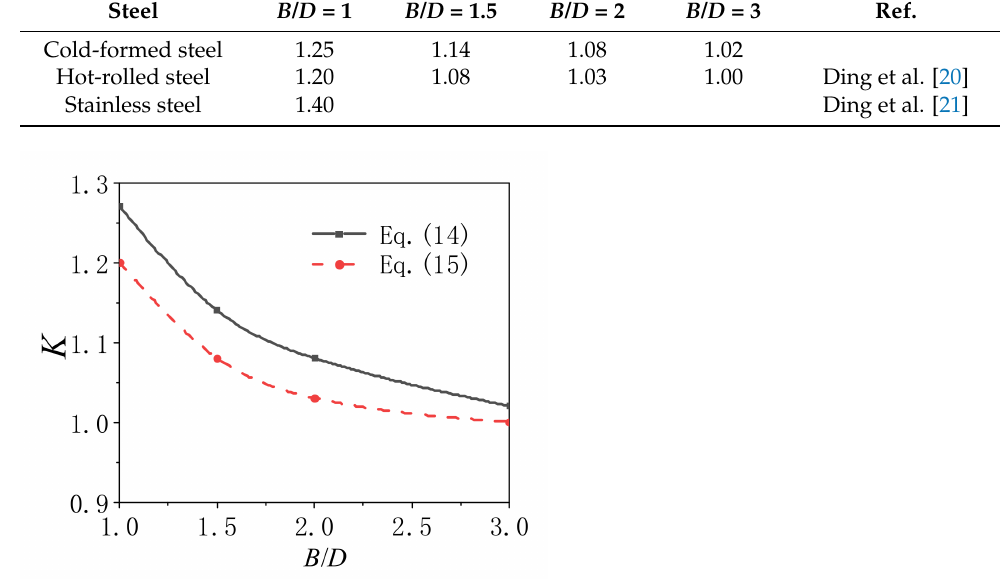
Figure 13. K of CFCFST and CFST stub columns with different B / D